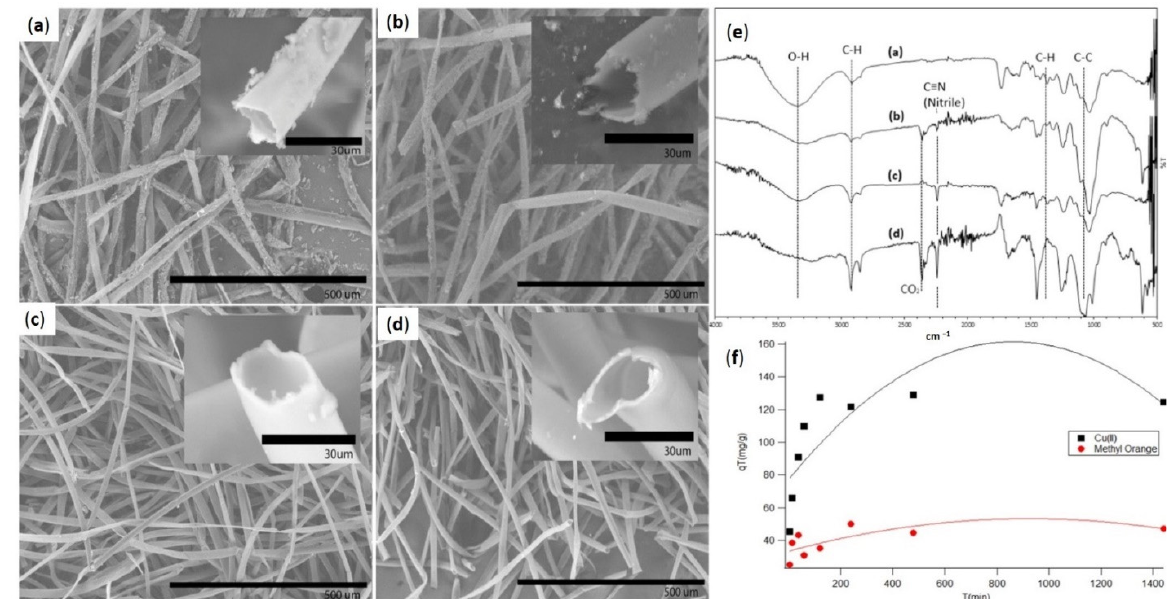
Figure 10. SEM scans of kapok fibers after PAN coating with ( a ) 10, ( b ) 15, ( c ) 20, and ( d ) 30, CTAB. The PAN-kapok fibers are seen with extreme intensity in the inset. Kapok fibers are 30 mg, PAN is 1.5 mL, and KPS is 60 mg; ( e ) FTIR bands of ( a ) pure kapok, ( b ) PAN-kapok mixtures made with ( a ) 10, ( b ) 20, and ( d ) 40 mg of CTAB. ( f ) The impact of interaction time on the adsorption performance of PAN-kapok hollow microtubes for Copper (II) and Methyl Orange from an aqueous solution. Reprinted with permission from Ref. [105]. Copyright 2017, copyright